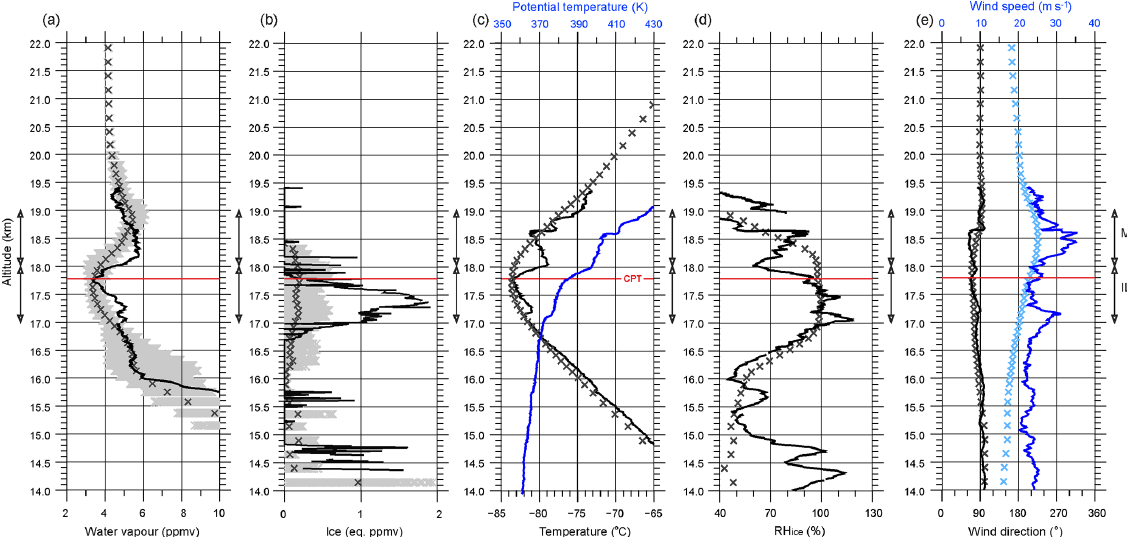
Figure 2. Vertical profiles of (a) water vapour (ppmv), (b) ice (eq.ppmv), (c) temperature ( ◦ C) and potential temperature (K), (d) relative humidity respect to ice (RH ice ; %), and (e) wind direction (degree) and speed (ms − 1 ) . In (a) – (e) , the measured values along the blue- coloured track between 25 and 26.5 ◦ N (shown in Fig. 1) from 06:20 to 06:48UTC on 8 August 2017 are shown as solid line, while the domain-averaged values in the region “HYD” (25–26.5 ◦ N, 85–85.5 ◦ E; shown in Fig. 1) from the Meso-NH simulation at 06:00UTC on the same day are shown as crosses. In (a) – (e) , the level of cold-point tropopause (CPT) is indicated by a red line. In (a) and (b) , all the values from Meso-NH within the “HYD” are displayed as grey crosses. The layers of the ML and IL are marked by